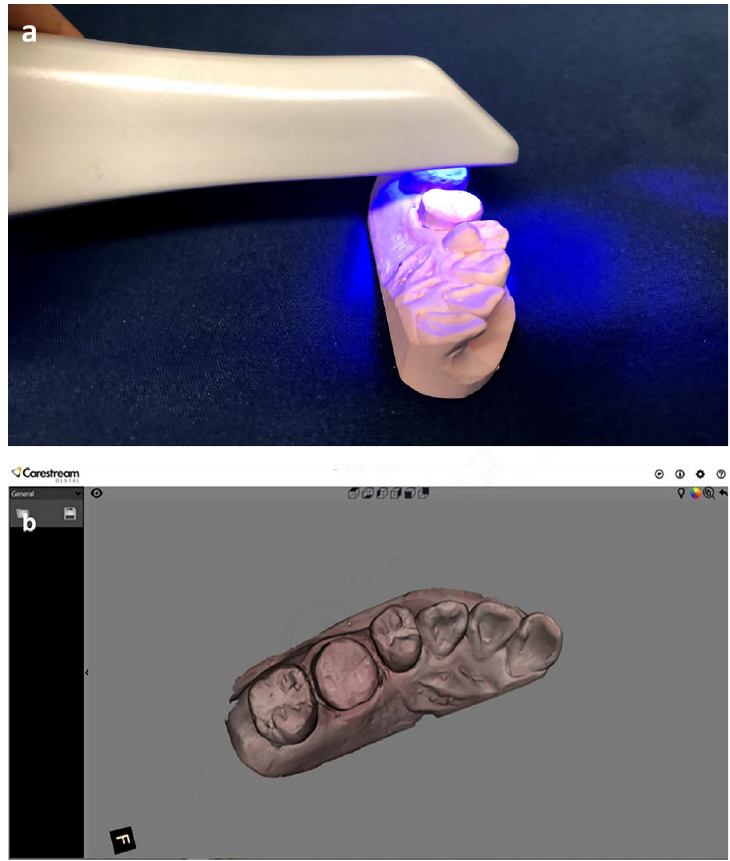
Fig 6. Intraoral optical scanning. (a) Scanned with an intraoral optical scanner (CS 3600), (b) saved in the STL format.